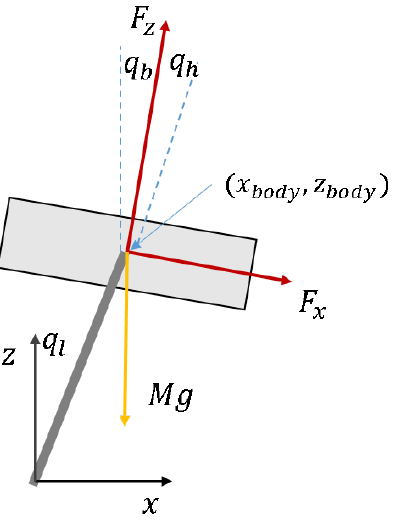
Figure 6. Free body diagram for